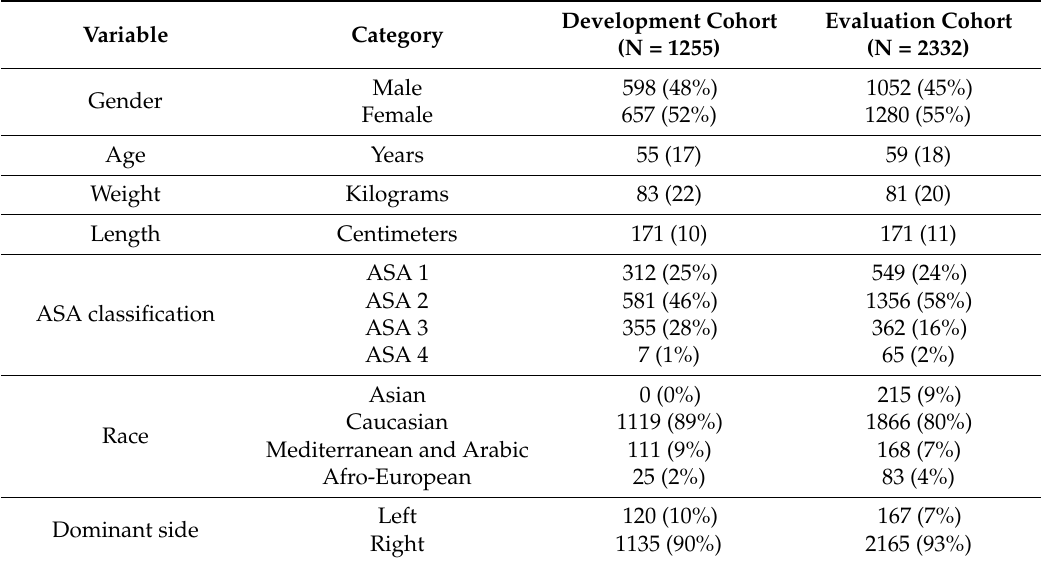
Table 1. Demographics and baseline characteristics of the included